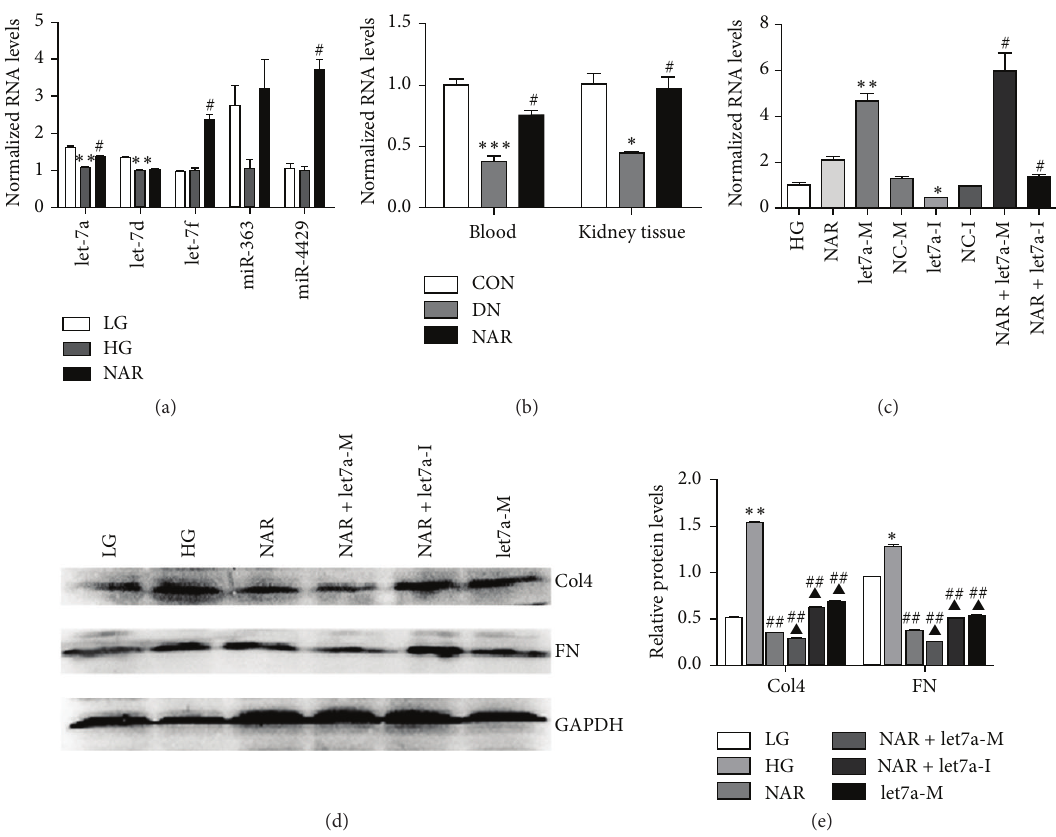
Figure 3: NAR inhibited deposition of ECM by upregulating let-7a expression. (a) MiRNAs expressions in MMCs treated with NAR. (b) Real-time RT PCR analysis of let-7a in blood and kidney tissues of rats. (c) Real-time RT PCR analysis of let-7a expressions. Data showed let-7a was upregulated or downregulated by let-7a mimics or let-7a inhibitor. Moreover, let-7a was increased in NAR group compared with HG untreated group. (d) Western blot analysis of Col4 and FN proteins in MMCs transferring let-7a mimics or inhibitor with NAR. (e) Quantifications of the western blot bands of Col4 and FN expressions in MMCs transferring let-7a mimics or inhibitor with NAR. (a) Results were normalized with U6 and expressed as mean ± standard deviation ( 𝑛 = 3 per group). ∗∗ 𝑝 < 0.01 versus LG group; # 𝑝 < 0.05 versus HG group.(b)ResultswerenormalizedwithU6andexpressedasmean ± standarddeviation( 𝑛 = 4 pergroup). ∗ 𝑝 < 0.05 ; ∗∗∗ 𝑝 < 0.001 versus CON group; # 𝑝 < 0.05 versus DN group. (c) Results were normalized with U6 and expressed as mean ± standard deviation ( 𝑛 = 3 per group). ∗ 𝑝 < 0.05 ; ∗∗ 𝑝 < 0.01 versus HG group; # 𝑝 < 0.05 versus NAR group. (e) Results were normalized with GAPDH and expressed as mean ± standard deviation ( 𝑛 = 3 per group). ∗∗ 𝑝 < 0.01 versus LG group; ## 𝑝 < 0.01 versus HG group; 󳵳 𝑝 < 0.05 versus NAR